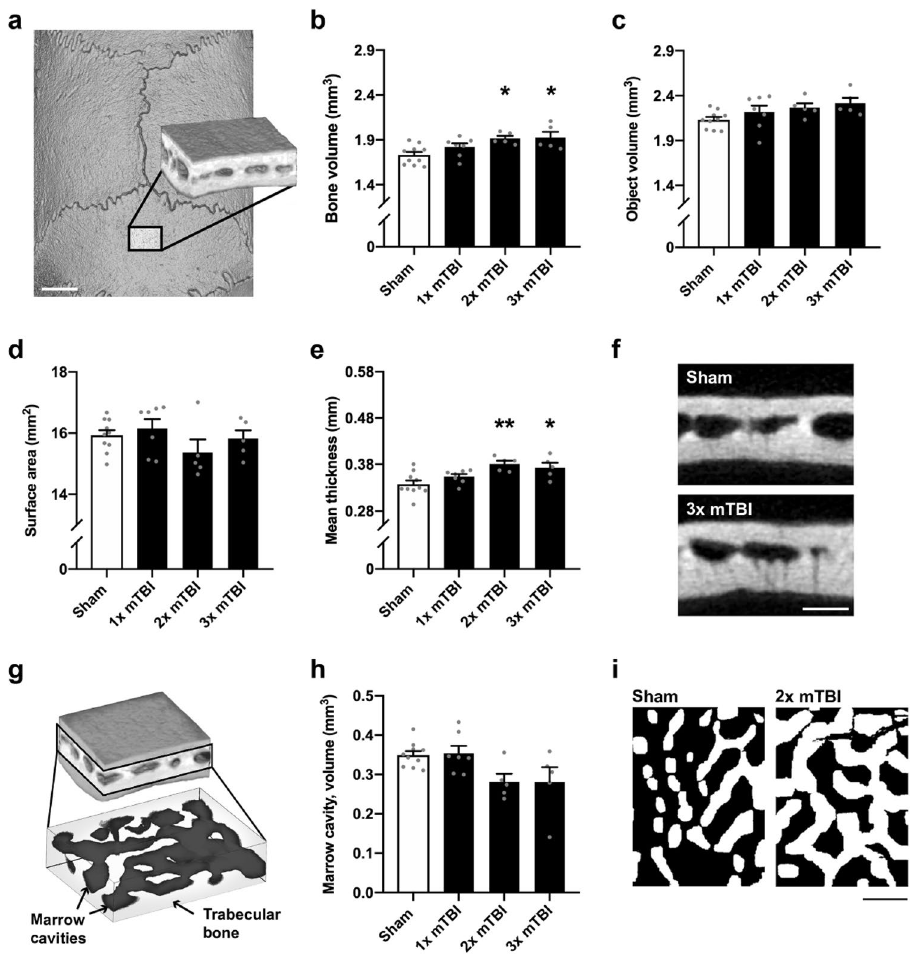
Figure 2. Modest increases in bone volume and thickness of the interparietal bone two weeks after rmTBI. The interparietal bone region-of-interest (ROI) is depicted in ( a ), which consisted of 150 microCT images sampled at the midline, caudal to the Lambda suture margin (scale bar = 2 mm). Quantification of mineralized bone volume ( b ) and mineralized bone thickness (e) revealed an increase in 2× and 3× mTBI mice compared to sham controls (post-hoc, *p < 0.05, **p < 0.005); whereas no significant differences were observed between groups in total object volume ( c ) or surface area ( d ). Representative Sham and 2× mTBI greyscale microCT images ( f ) illustrate modest bone thickening with rmTBI (scale bar = 500 µm). In ( g ), bone marrow cavities (dark grey) were isolated from trabecular bone (light grey) in the diploë region of the interparietal bone scan ROIs for volumetric analysis ( h ), revealing a reduction in marrow cavity volume (one-way ANOVA p = 0.02; post-hoc n.s.). Representative superior-view, binary projections of the diploë ( i ) illustrate a subtle reduction in marrow cavities with injury (scale bar = 500 µm; black indicates marrow cavity and white indicates bone). N = 5–10/ group; one-way ANOVAs with Tukey’s post-hoc as